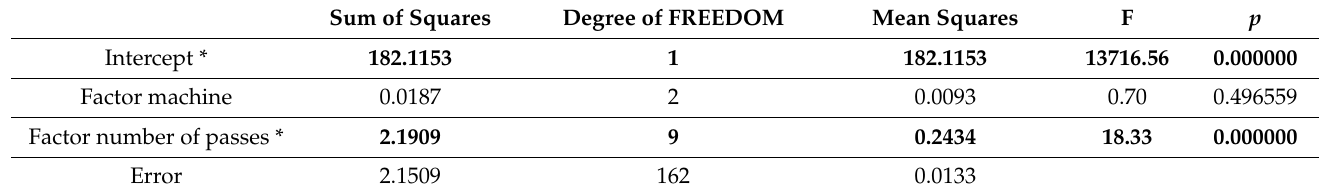
Table 3. ANOVA of the bulk density, the machine types, and the number of machine passes. Sum of Squares Degree of